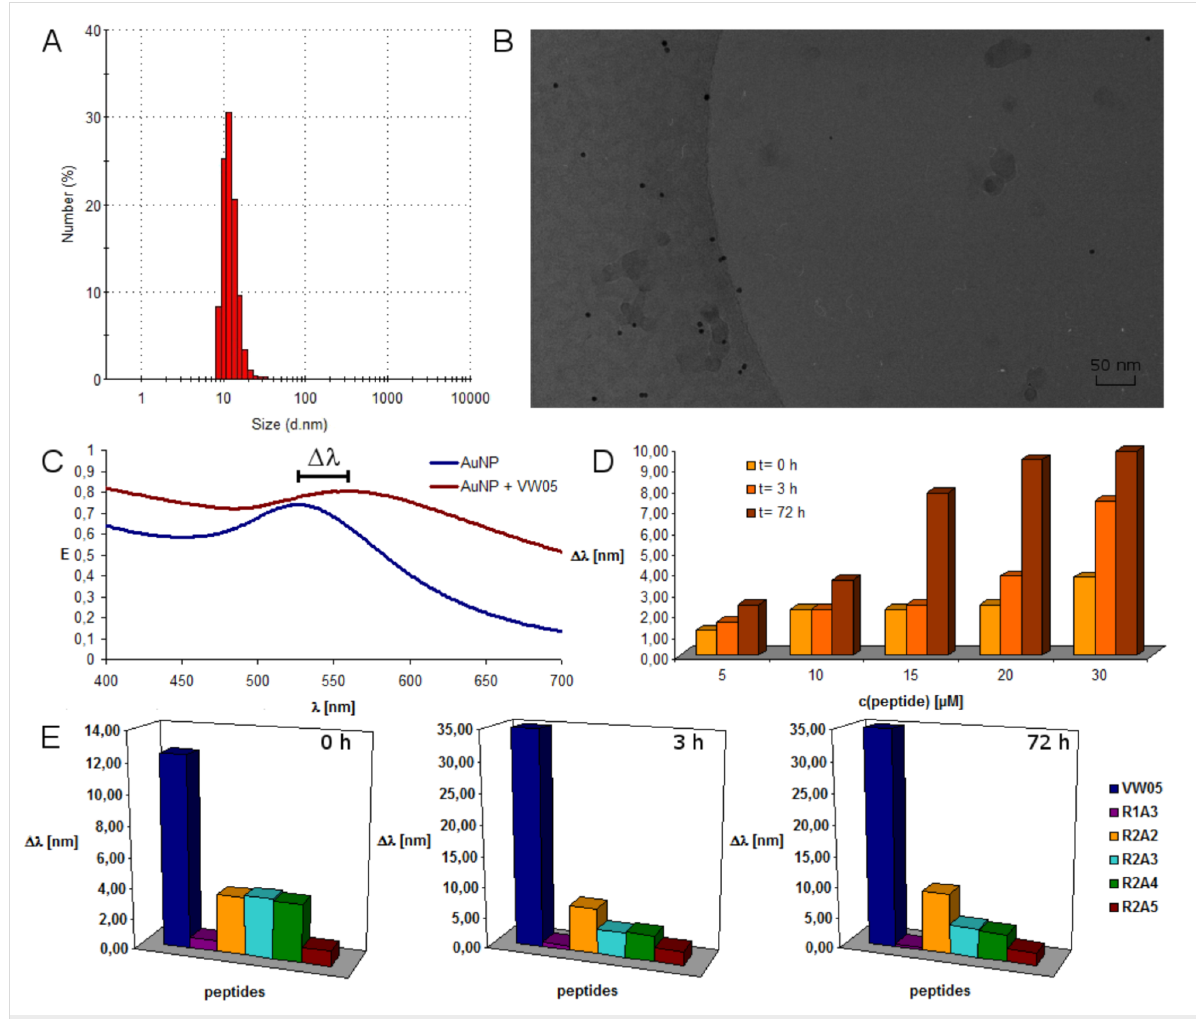
Figure 4: (A) Dynamic light scattering of 0.05 µM Au/MUA nanoparticles at pH 9. (B) Cryo TEM image of 0.05 µM Au/MUA nanoparticles at pH 9. (C) UV–vis spectra of 0.05 µM Au/MUA nanoparticles at pH 9 and in the presence of 30 µM VW05. (D) Time and concentration dependent shift in the absorption maximum of 0.05 µM Au/MUA nanoparticles in the presence of different amounts of R2A2. (E) Time-dependent shift in the absorption maximum at a fixed peptide concentration of 30